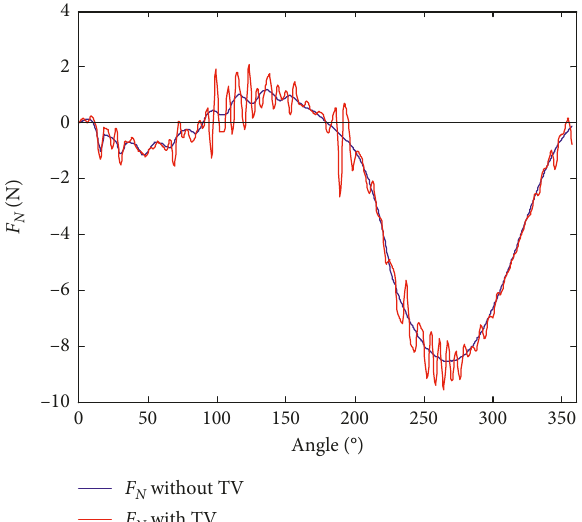
Figure 9: Side-thrust force F